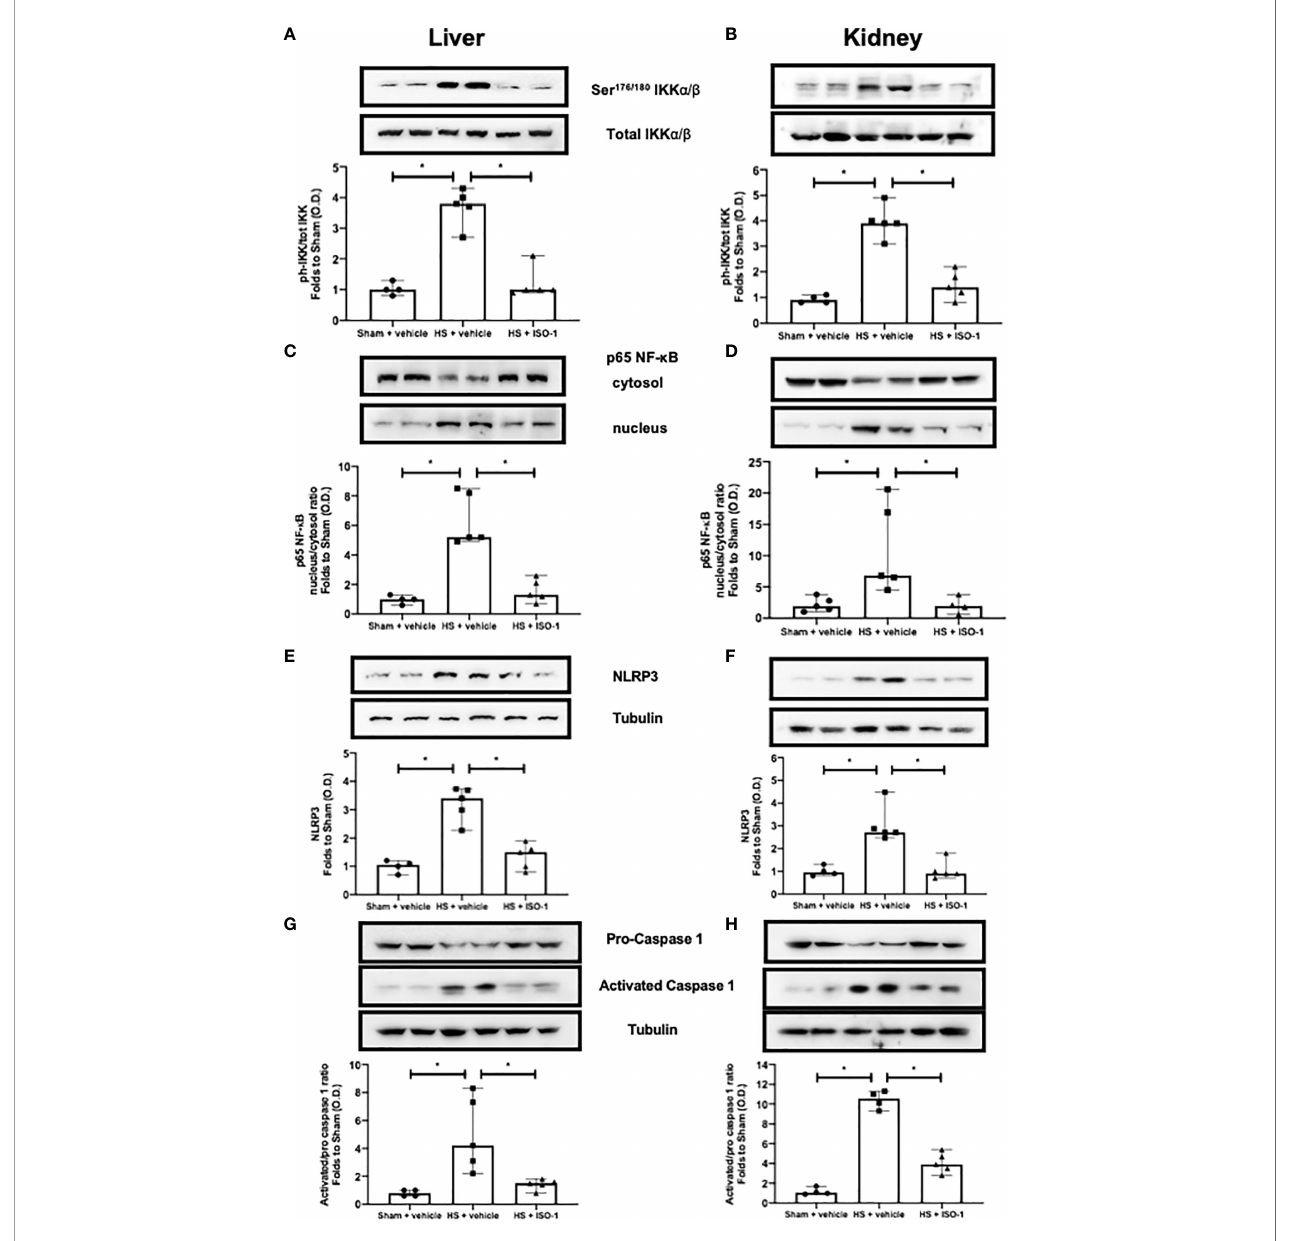
FIGURE 4 | Treatment with ISO-1 attenuates NF- k B and NLRP3 activation in a short-term follow-up acute HS model. (A, B) The phosphorylation of IKK a / b at Ser 176/180 , (C, D) nuclear translocation of p65, (E, F) activation of NLRP3 and (G, H) cleavage of pro-caspase 1 of vehicle and ISO-1 treated rats were determined by western blot in the liver and kidney. Protein expression was measured as relative optical density (O.D.) and normalised to the sham band. Data are expressed as median with range of 4-5 animals per group. Statistical analysis was performed using one-way ANOVA followed by a Bonferroni ’ s post-hoc test. *p < 0.05 denoted statistical signi fi